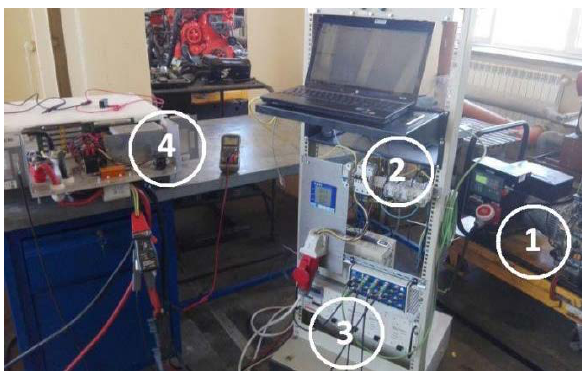
Fig. 4 Charging test stand: 1 – power generator, 2 – current-voltage pa- rameters acquisition system, 3 – constant-current power station, 4 – battery − LiFePO 4 battery discharging stand (Fig. 5). Test